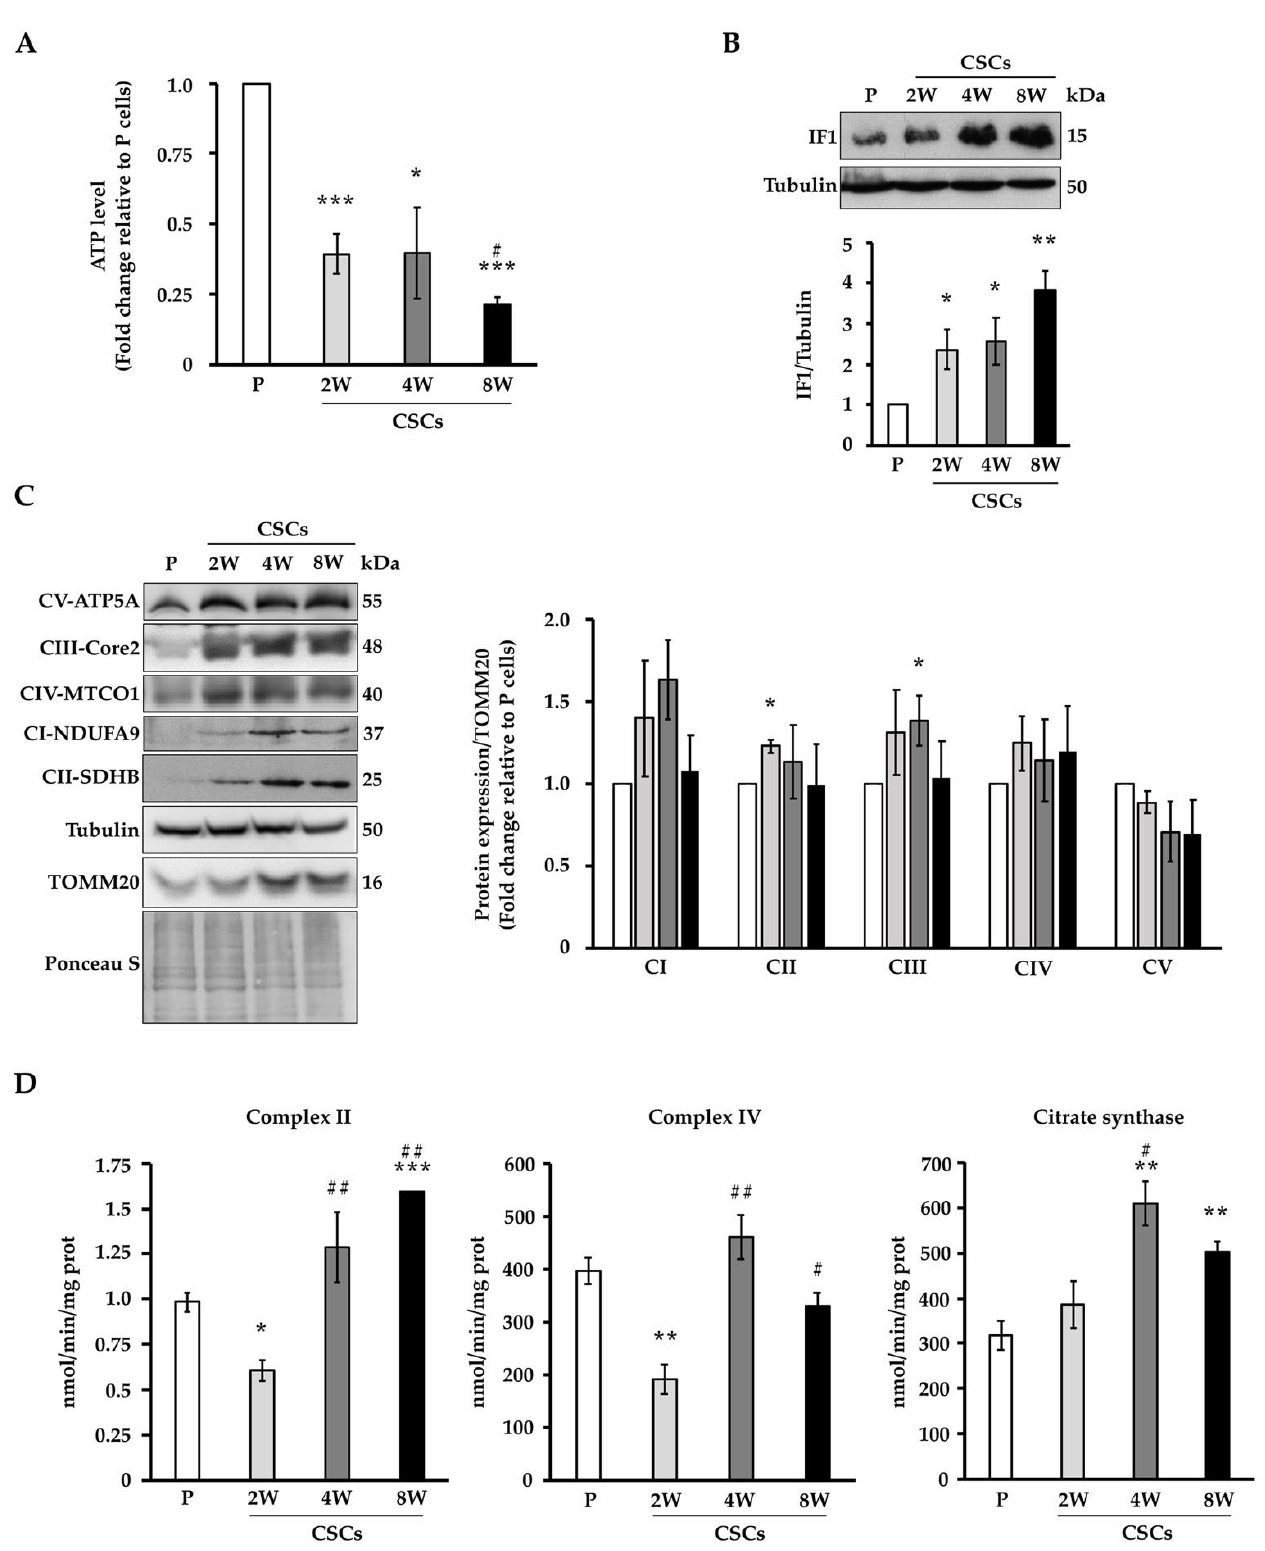
Figure 6. CSCs show modulation of the mitochondrial respiratory complex amounts and activities. ( A ) ATP levels of Panc1 parental and CSCs. ( B ) Representative immunoblot of ATPase inhibitory factor 1 (IF1) and densitometric quantification (histogram) of three different biological replicates of IF1 expression. Tubulin is shown as a loading control. ( C ) Right panel, representative immunoblots of three different biological samples of the expression of mitochondrial respiratory proteins from complex I (NDUFA9), complex II (SDHB), complex III (core2), complex IV (MTCO1), and complex